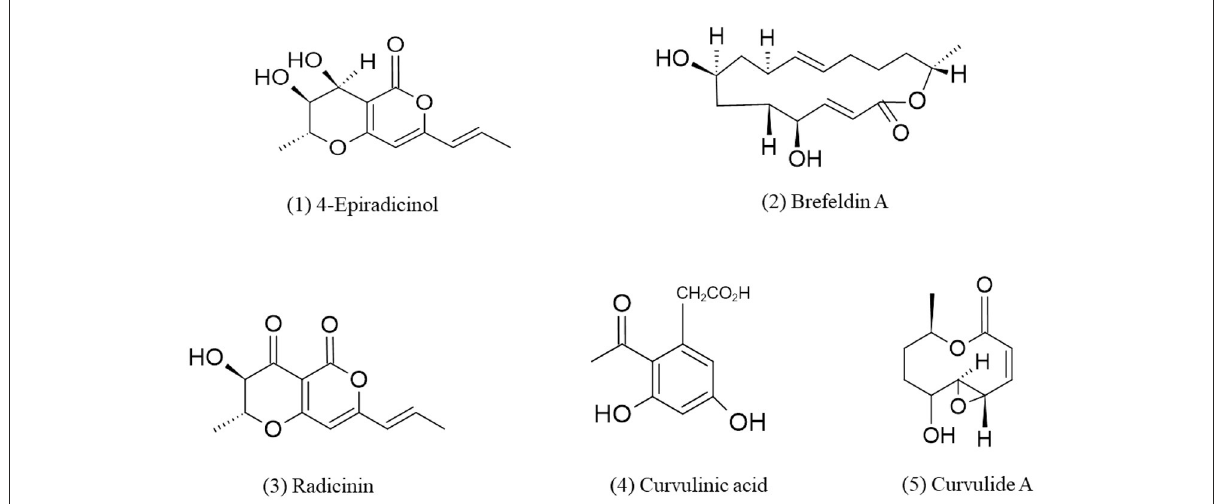
FIGURE1 Chemical structures of bioactive compounds of polyketides family of Curvularia spp. (1) 4-Epiradicinol, (2) Brefeldin A, (3) Radicinin, (4) Curvulinic acid, and (5) Curvulide A.